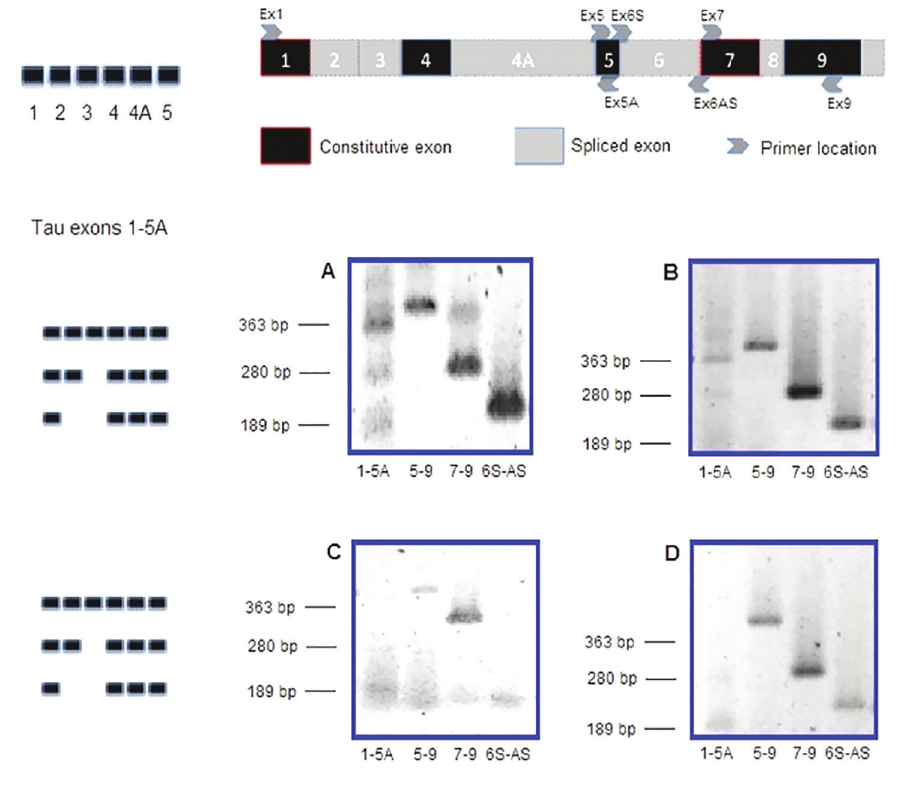
Figure 3 - Representations of protein tau, exons 1 to 9 (modified from Vanier et al. 1998) and the exons 1 to 5 comprised in the region amplified by primer pair Ex1/Ex5A. Expression of tau exons 2/3 (Ex1/Ex5A), 6 (Ex5/Ex9, Ex6S/Ex6AS) and 8 (Ex7/Ex9) from: untreated A) undifferentiated and B) NGF-induced differentiated PC12 cells; and from PC12 cells exposed to Aβ undifferentiated and D) NGF-induced differentiated cells. Differentiation inhibits fetal tau expression. Aβ exposure promotes exclusion of exons 2/3 in undifferentiated and differentiated cells, and exclusion of exon 6 in undifferentiated